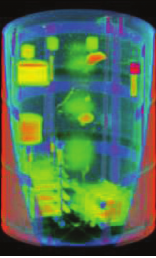
Fig. 22. Imagery of a nuclear